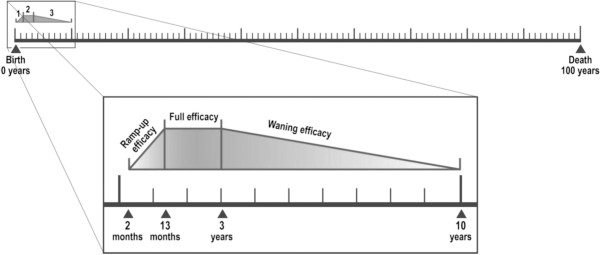
Modeling age-compartments and vaccine efficacy periods. Vaccine efficacy was modeled in three phases: initial ramp-up efficacy (2–13 months), full efficacy (13 months-3 years) and waning efficacy (3–10 years).